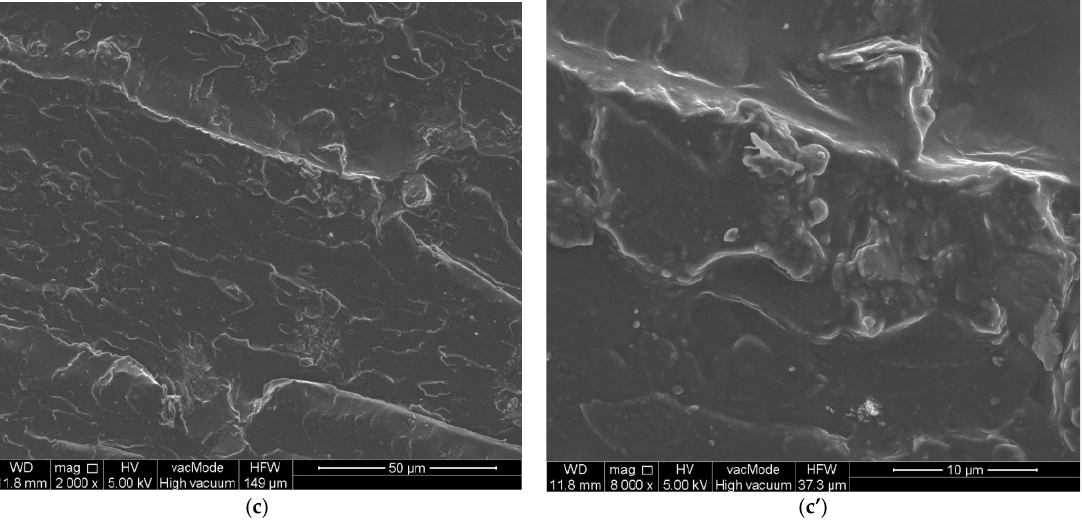
Figure 14. Microphotographs of the structure of the composites: ( a ) sample O (left side before strength tests, right side after strength tests); ( b ) KA10; ( c ) CL10.